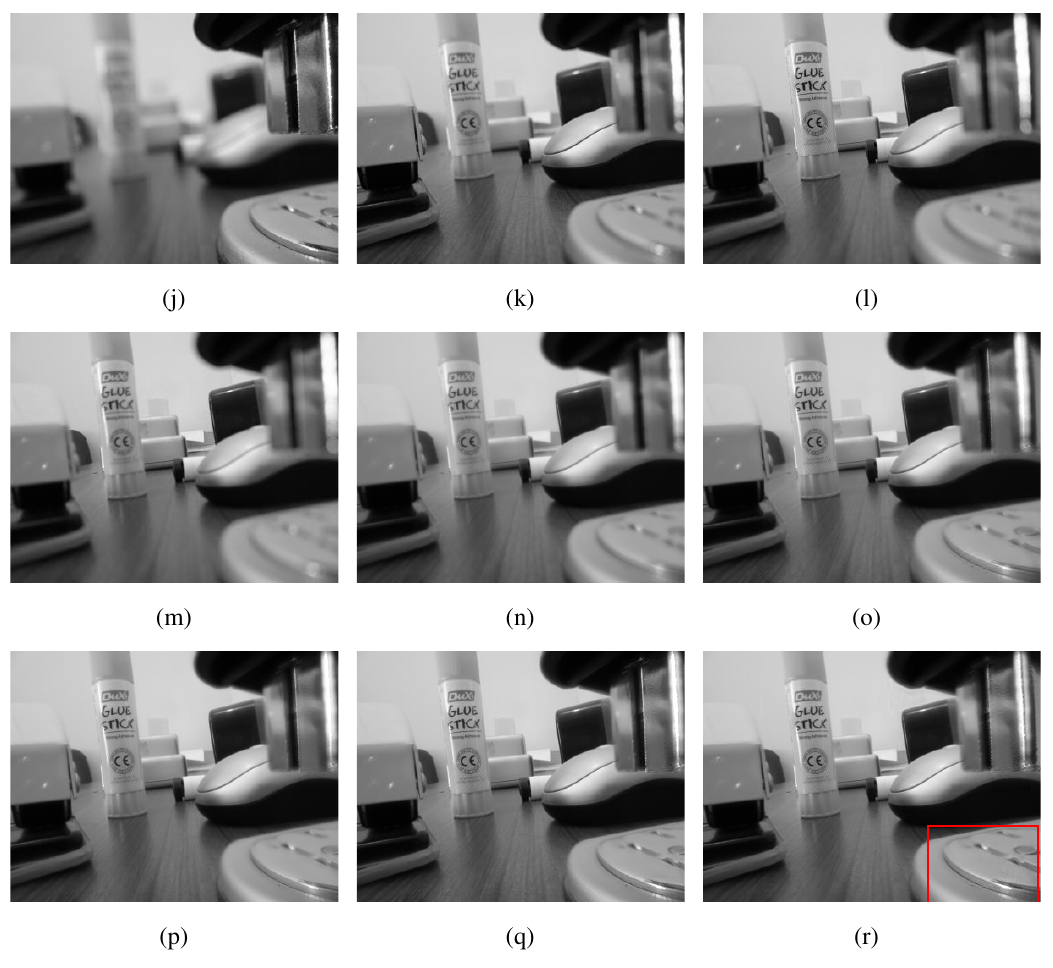
Figure 9. Multi-focus image fusion results for Dataset 1.